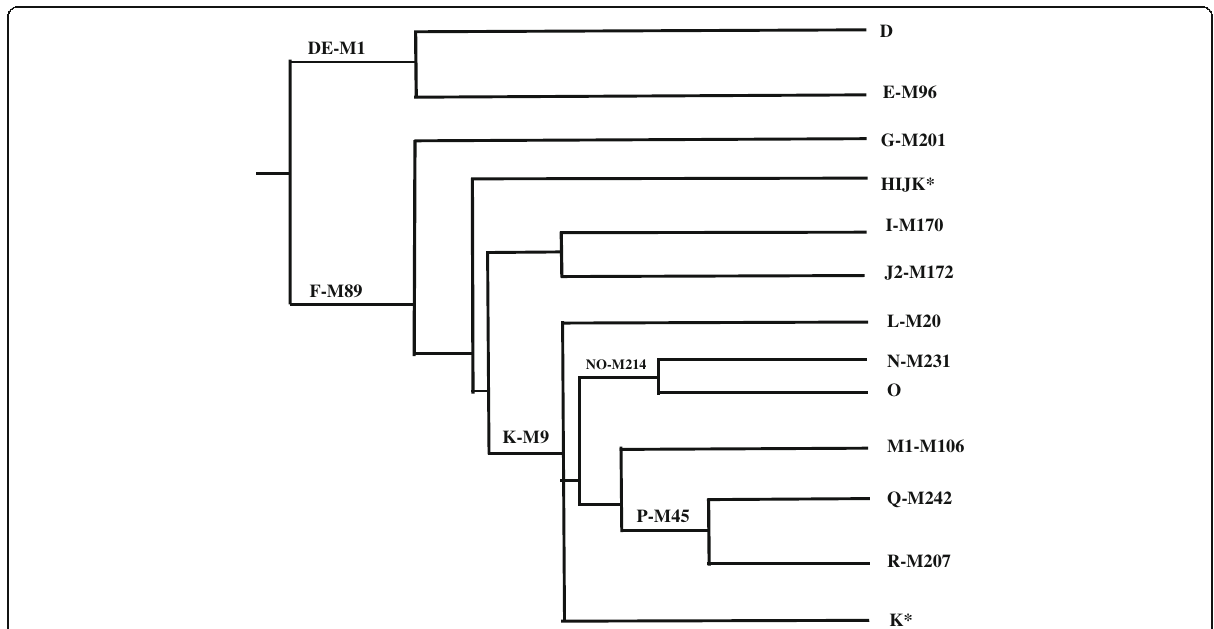
Fig. 1 Phylogenetic tree constructed with 14 Y chromosome markers based on the YCC nomenclature. The Y haplogroups were classified according to the presence/absence of various binary markers. Each haplogroup and the diagnostic markers are indicated in the roots and in the ends of the branches. The DE* (putative D) or NO* (putative O) and HIJK* haplogroups were defined by the absence of the typed SNPs [9,